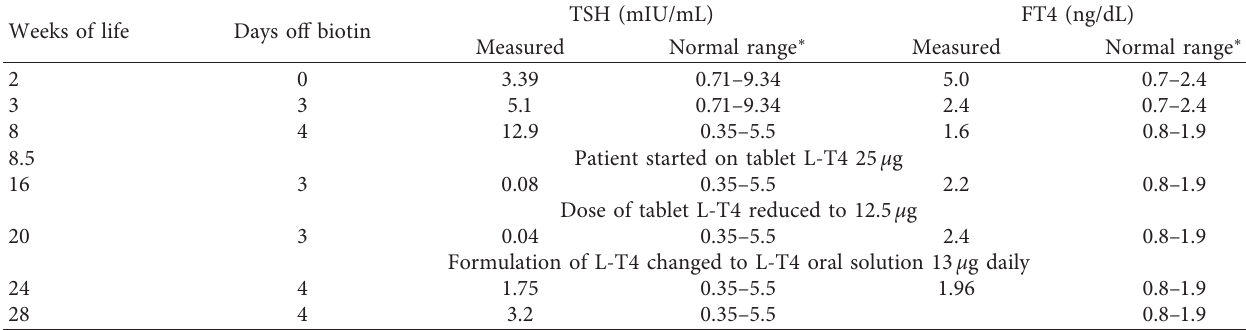
Table 1: Thyroid function tests after diagnosis of biotinidase